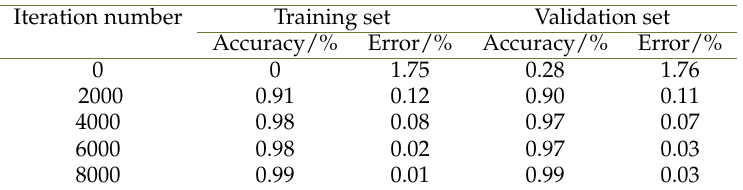
Table 3. Loss and accuracy of training